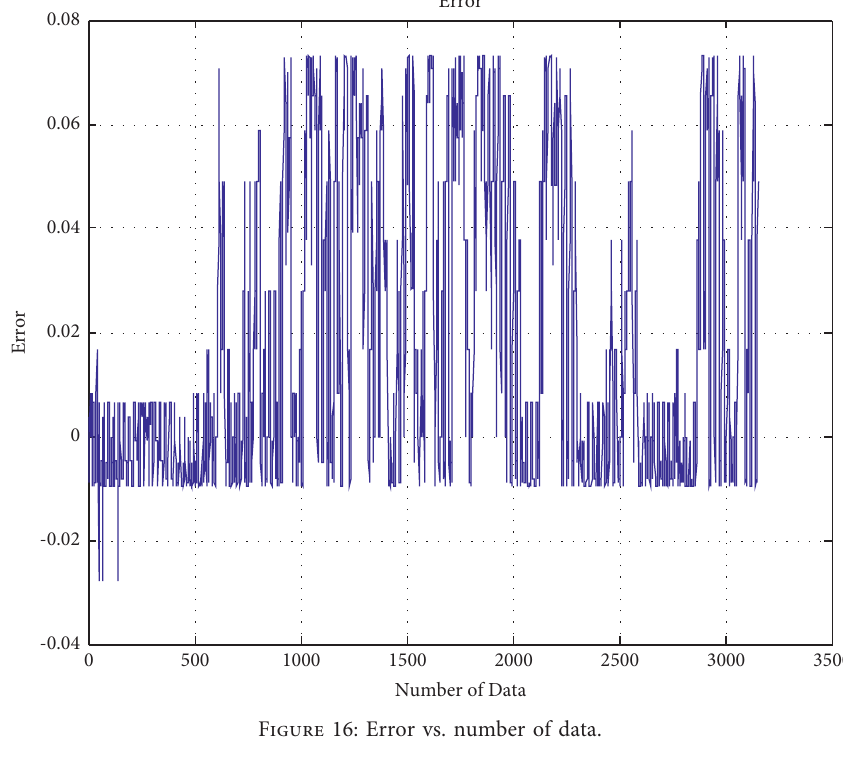
Figure 16: Error vs. number of data.